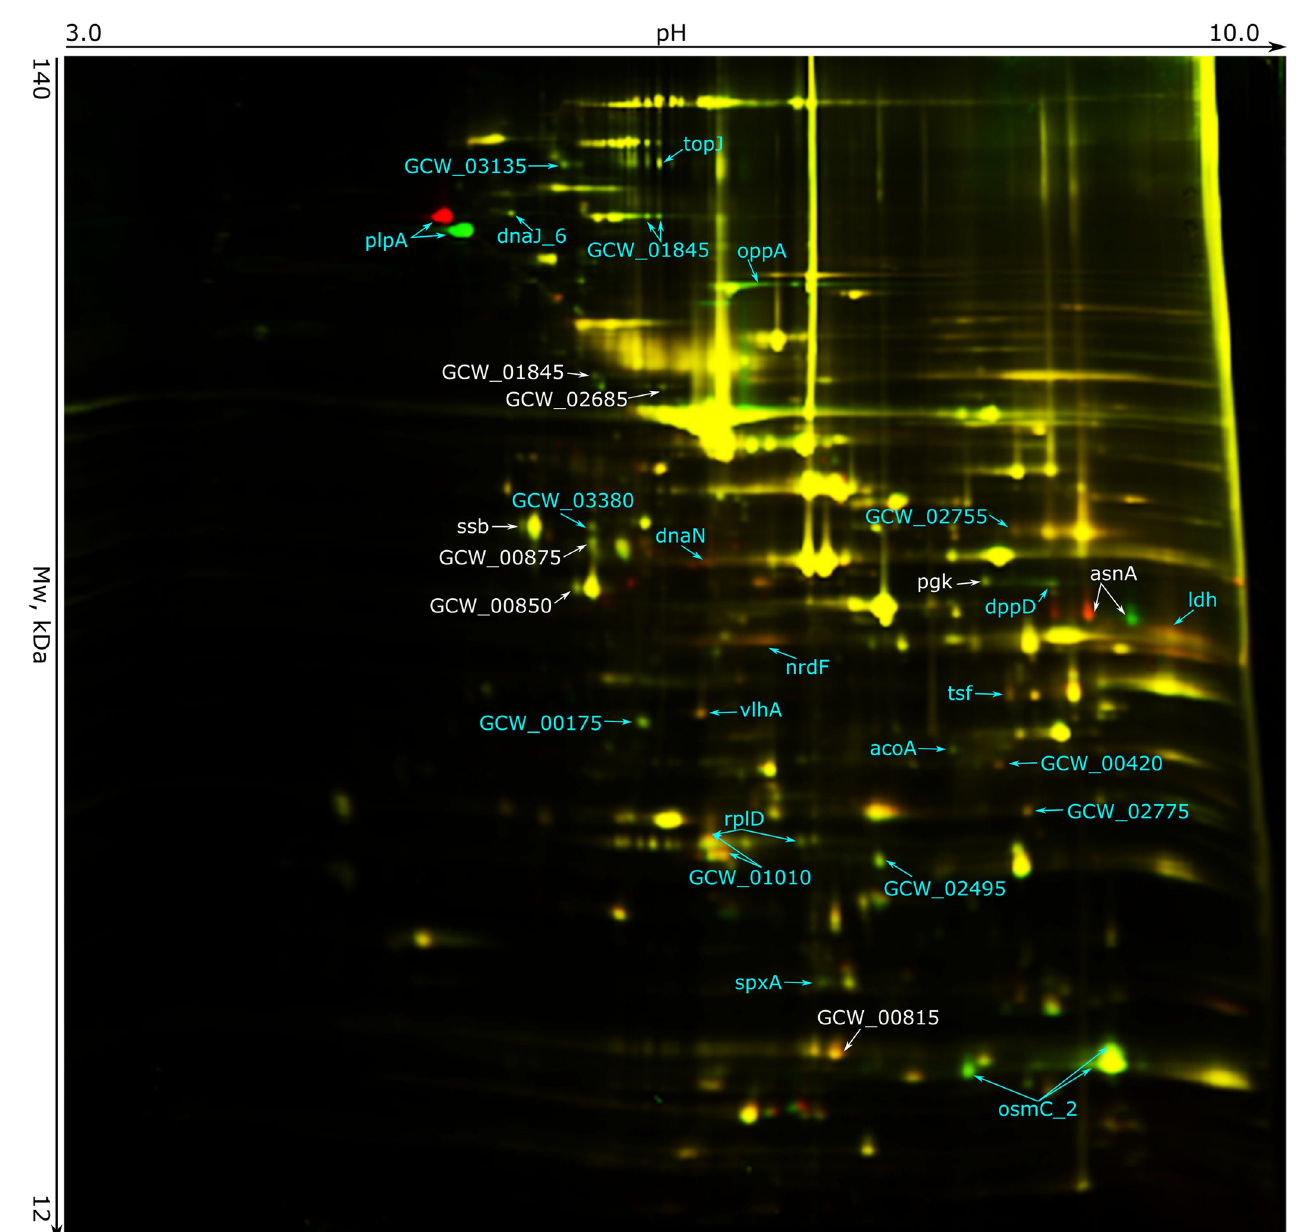
Fig 6. Comparison of the proteomic profiles of the wild-type M . gallisepticum (red) and the Δ S.MgaS6I strain (green) with unmethylated DNA. Proteins, whose abundances reproducibly changed in all the studied strains with tetM insertion in the various genomic regions, as compared to that in the WT, are in blue, while differences that are unique to Δ S.MgaS6I are in